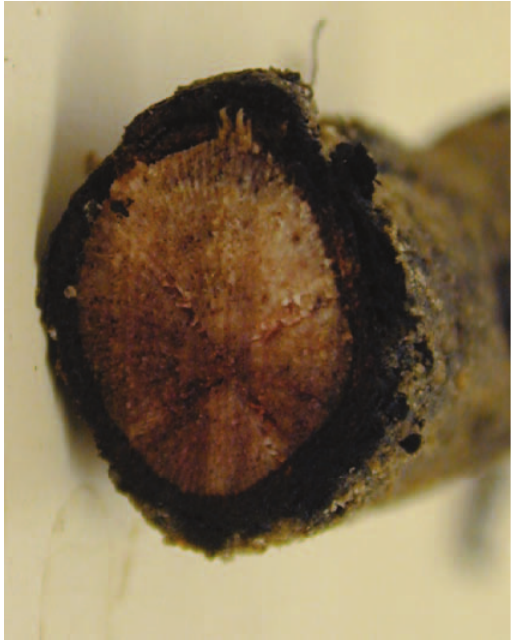
Fig. 3. Dark vascular streaking as seen in longitudinal sec- tion of a young grapevine infected with Cylindrocarpon spp.